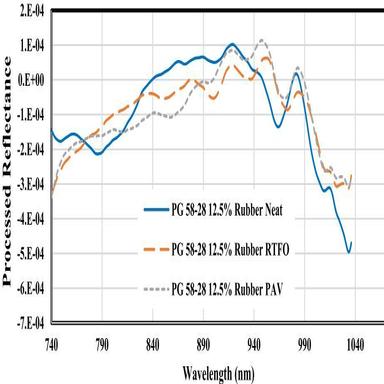
Comparison of the PG 58-28 binders with 12.5% rubber at different aging levels.